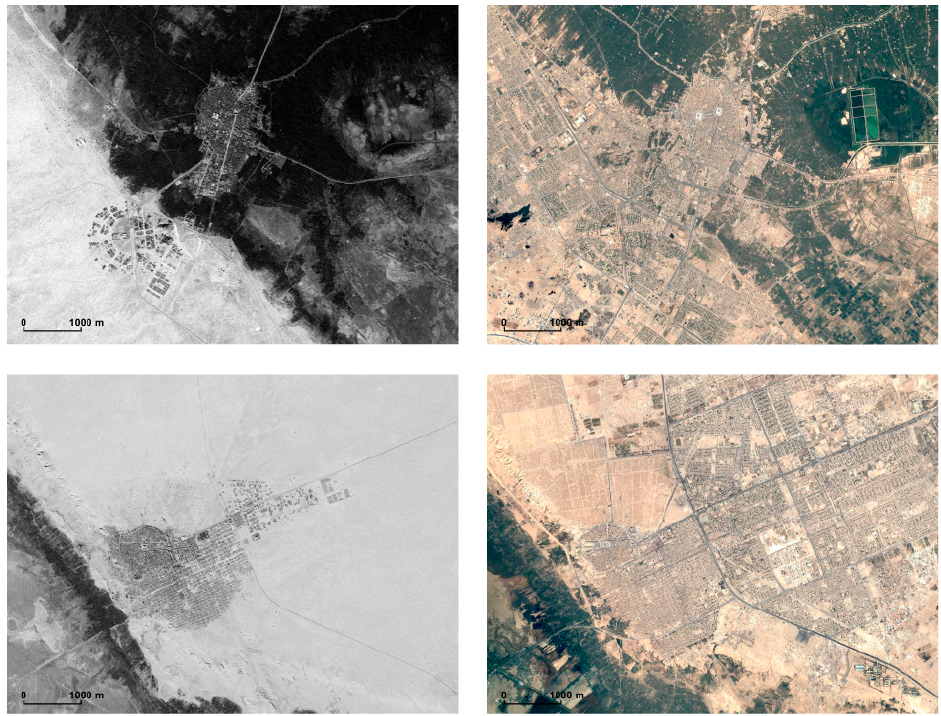
Figure 2. Top left : Karbala, 14 December 1962 (Corona mission 1050, image 136); top right : Karbala, 27 July 2004 (Google Earth); bottom left : Najaf, 14 December 1962 (Corona mission 1050, image 140); bottom right : Najaf, 15 September 2004 (Google Earth).